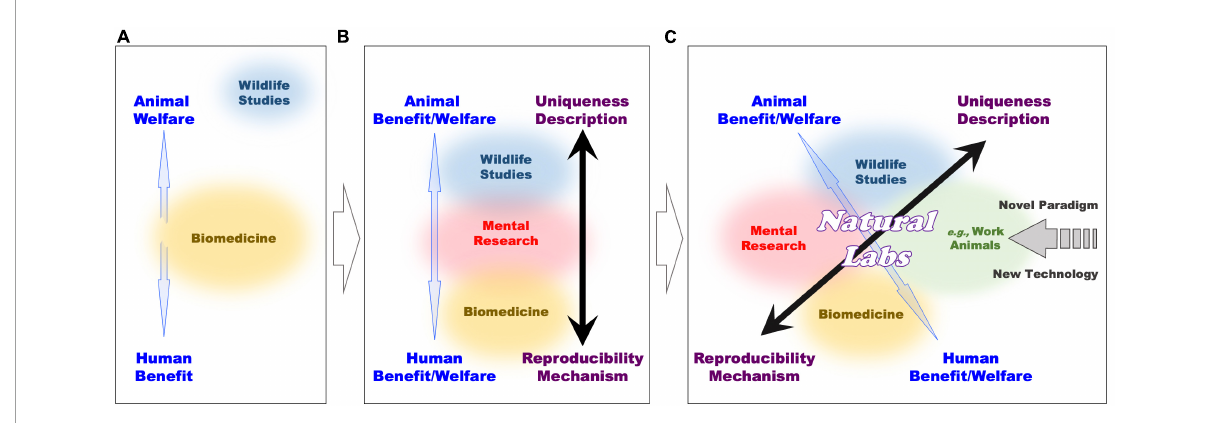
FIGURE3 Comparative representation of ethical and experimental frameworks in various domains of animal research, along progressive development of interactions among multiple sectors (see Box 1 text for further explanations).